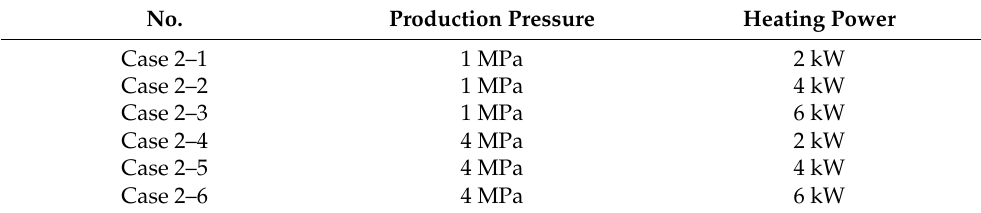
Table 4. Main production parameters for the inner wall heating